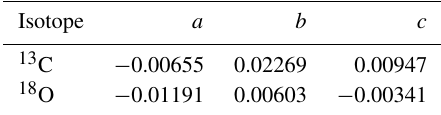
Table 2. The coefficients a , b , and c for Eq. (7) for 13 C and 18 O. Isotope